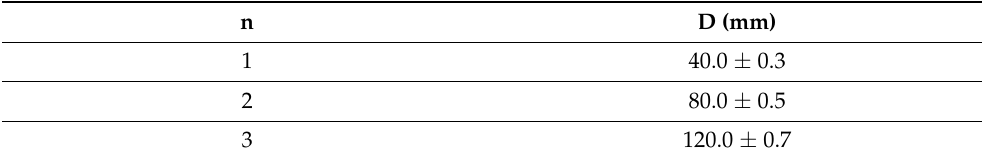
Table 2. Immersion depth D at which standing waves and thus nodes could occur with the given frequency in the CH141 hardener calculated with Equation